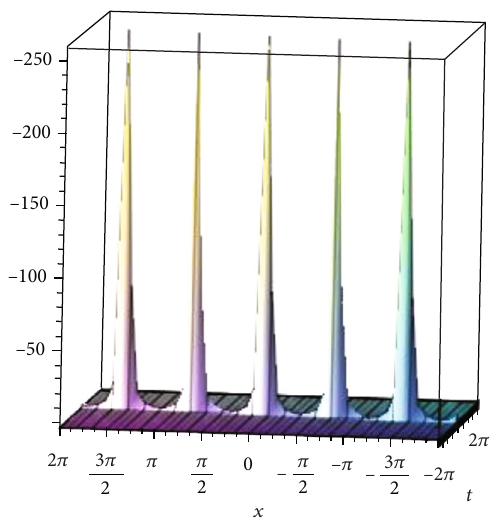
ð z Þ for the fi xed s ,1